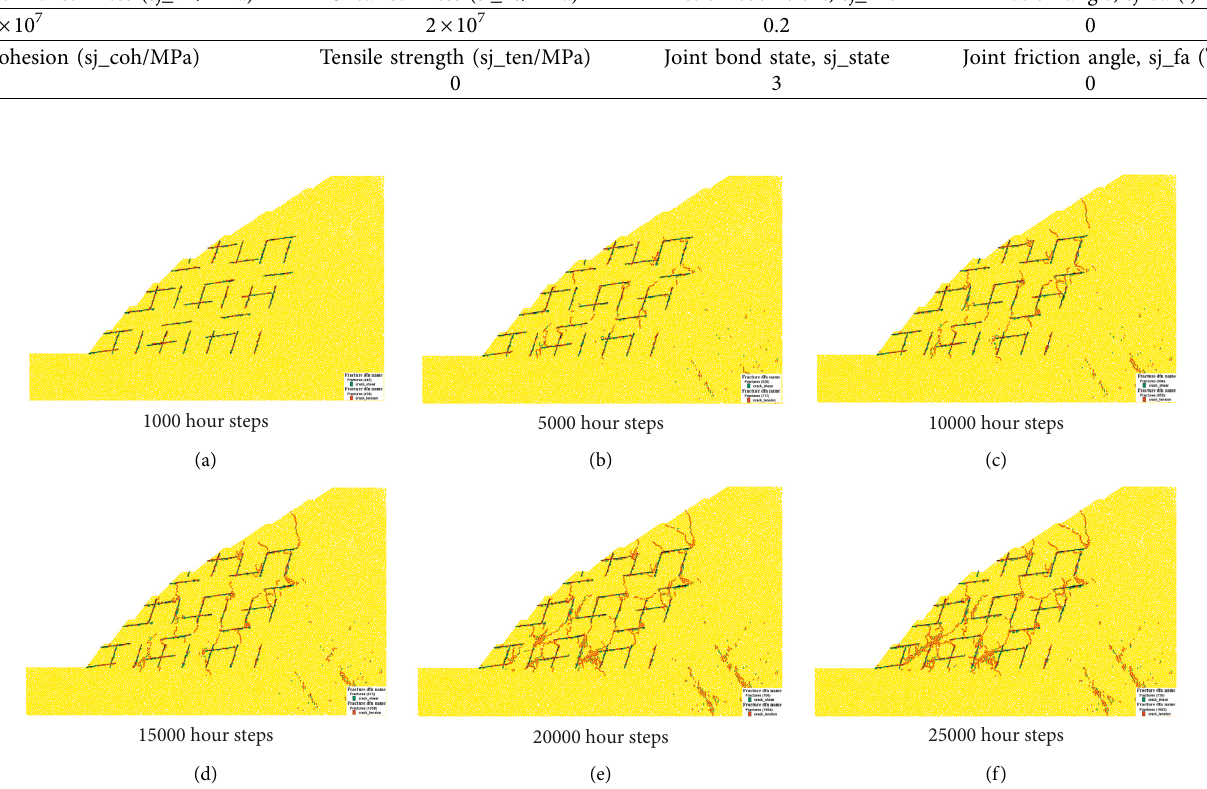
Figure 8: Mesoscale temporal and spatial development process of the rupture: (a) 1,000 hour steps, (b) 5,000 hour steps, (c) 10,000 hour steps, (d) 15,000 hour steps, (e) 20,000 hour steps, and (f) 25,000 hour